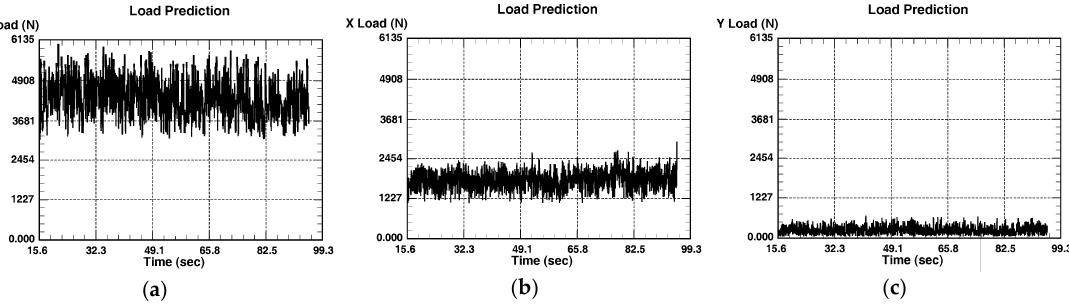
Figure 10. The forces obtained by numerical simulation in the second stage of the process for the 34th point of the experimental plan: ( a ) Axial force F z ; ( b ) longitudinal force F x ; ( c ) side force F y .